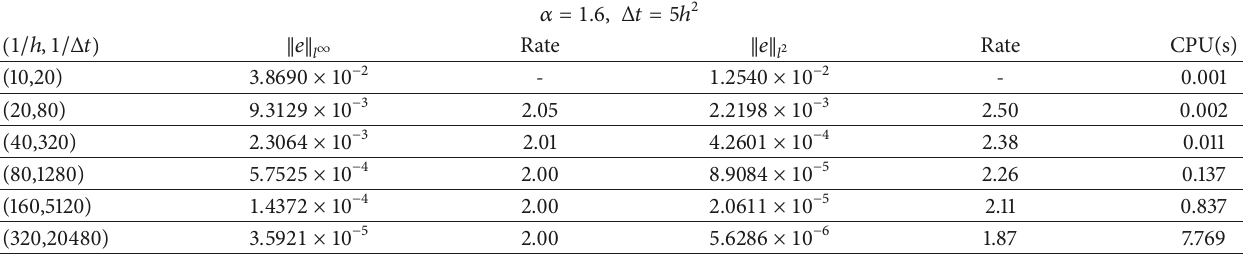
Table 7: Error and convergence rates for Example 2.